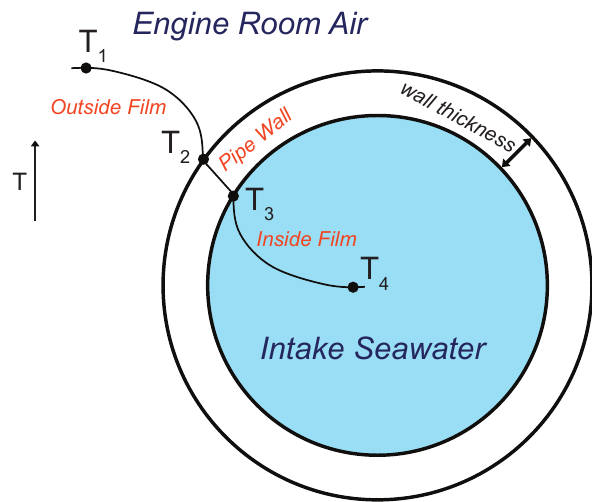
Fig. A2. Cross-section through the modelled intake pipe. An illus- trative temperature profile is shown by the solid black lines connect- ing temperatures T 1 , T 2 , T 3 and T 4 , with engine room air tempera- ture, T 1 , being the warmest.